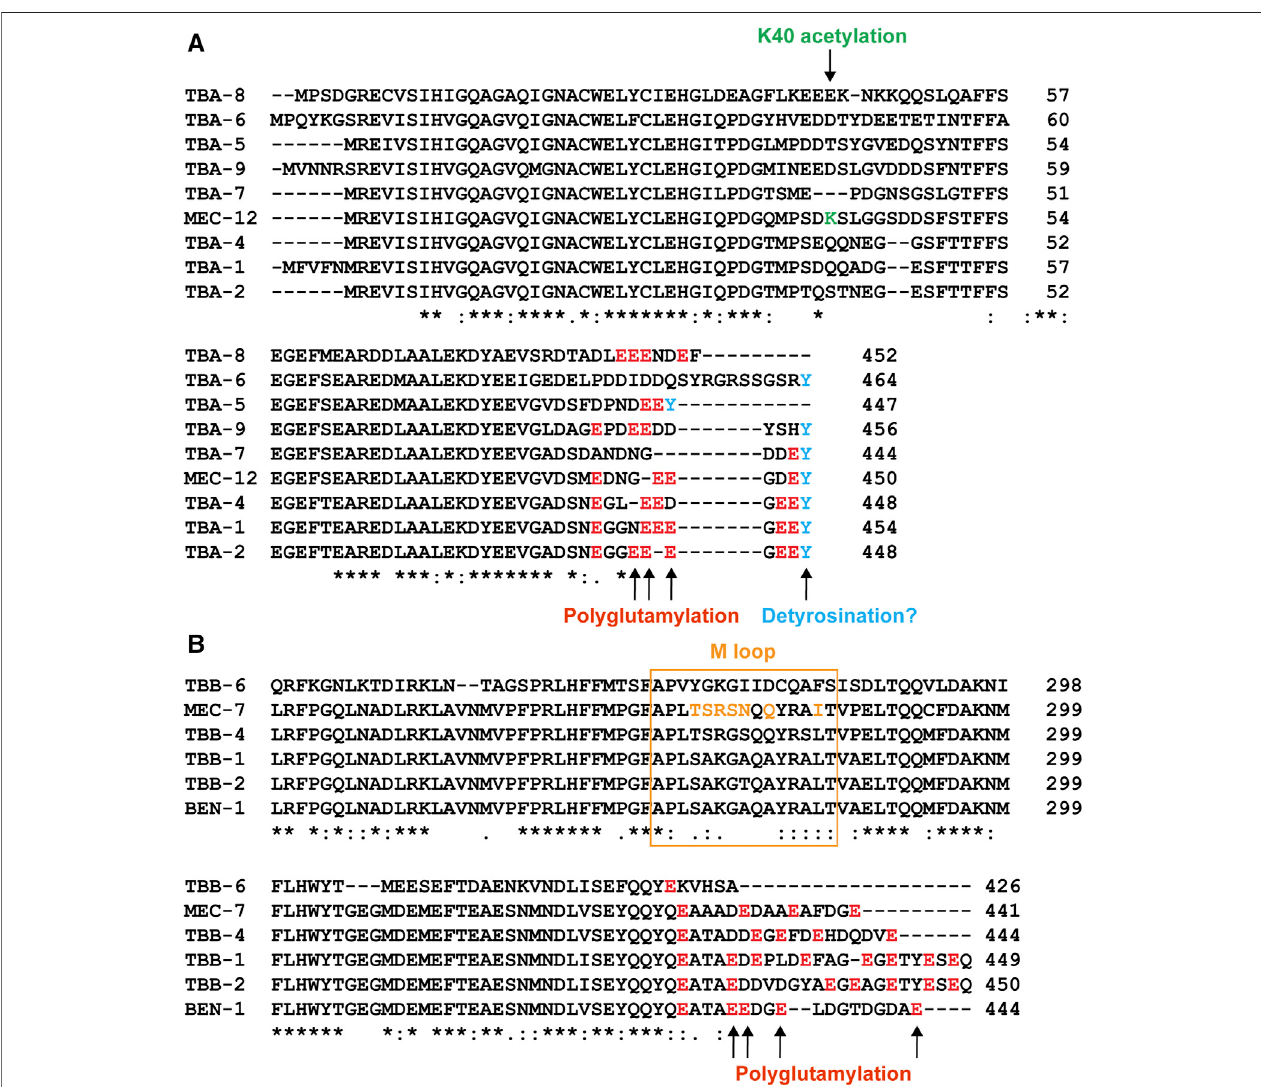
FIGURE4| Sequencevariationamongthetubulinisotypesin C.elegans .Alignmentofpartoftheaminoacidsequencesof α -tubulin (A) and β -tubulin (B) isotypes. Sites for potential PTMs were color-coded. Green for K40 acetylation, red for polyglutamylation, and blue for potential detyrosination. The sequence for the M loop is labeled by the orange box and the amino acids in the M loop of MEC-7 that differ from the ubiquitous TBB-1 and TBB-2 are in orange as well.